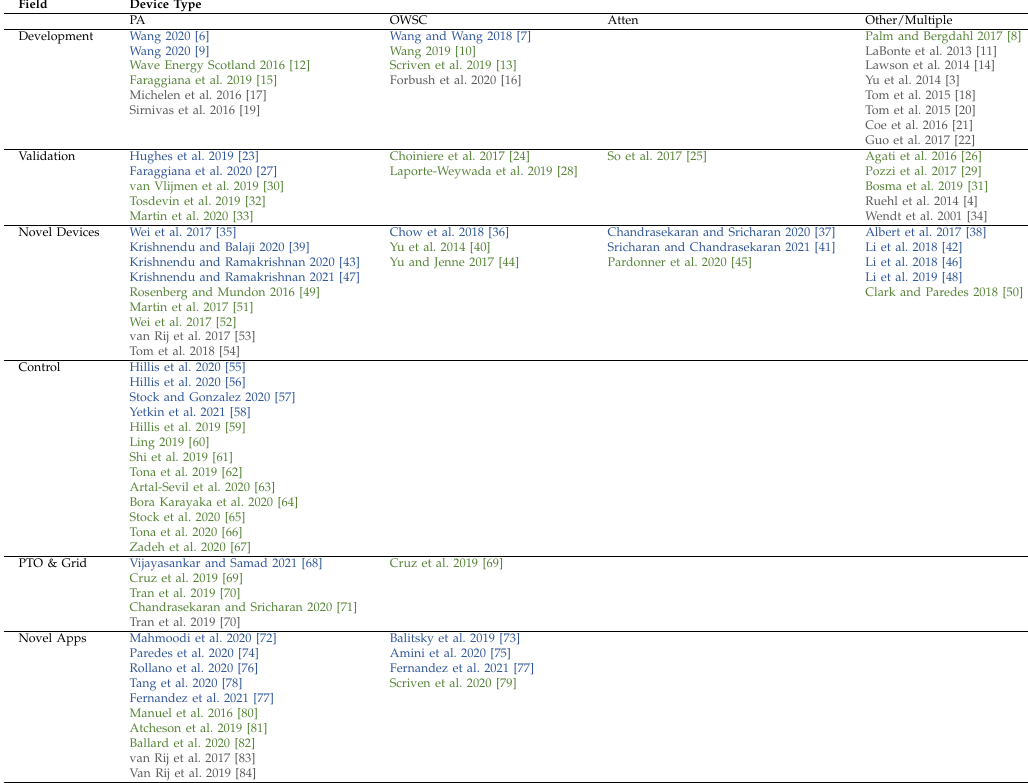
TABLE I O VERVIEW OF 95 PUBLICATIONS FEATURING WEC-S IM , ORGANIZED BY FIELD OF STUDY AND DEVICE TYPE . C OLOURS MATCH F IGURE